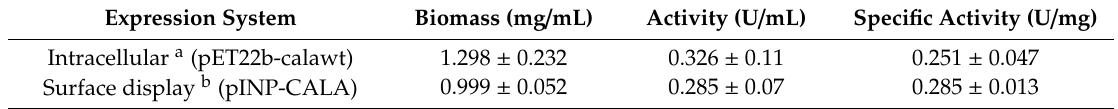
Table 1. Expression and activities of intracellular CALA and surface-displayed CALA.